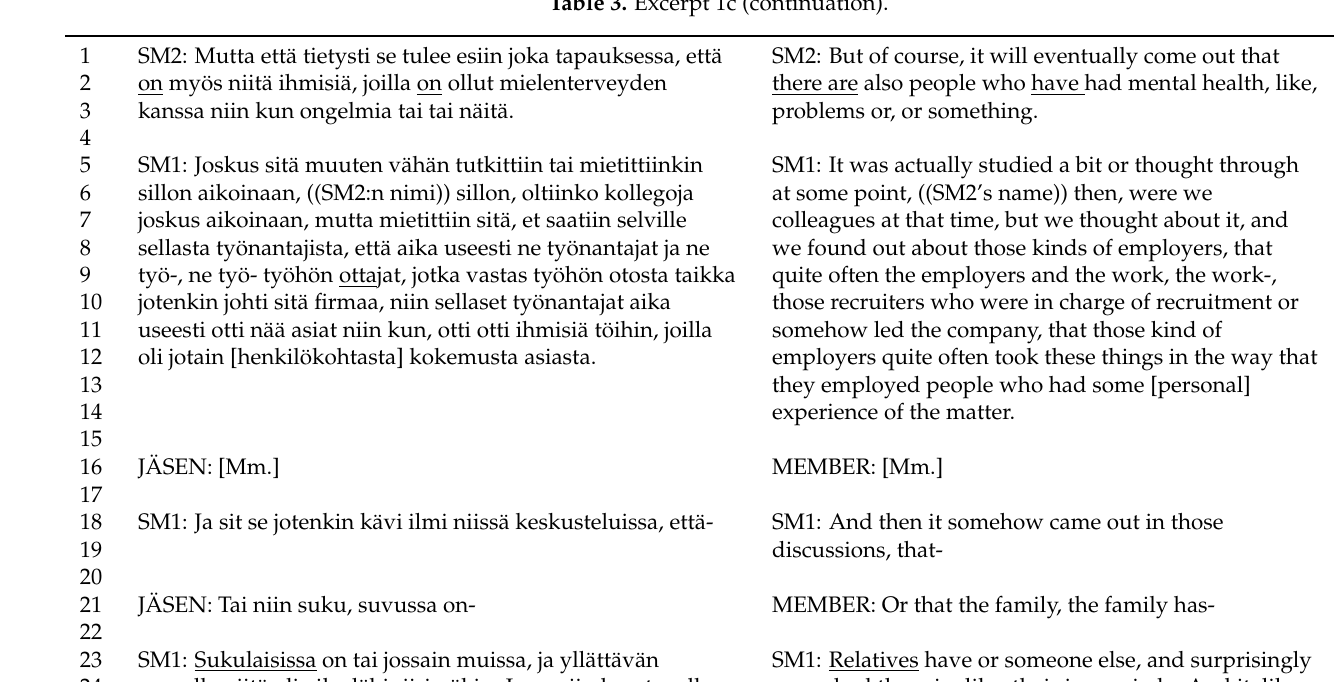
Table 3. Excerpt 1c